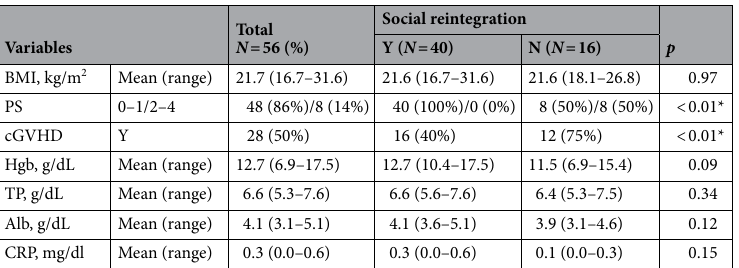
Table 2. Patient status at 2 years after allo-HSCT. BMI; body mass index, PS; performance status, cGVHD; chronic graft-versus-host disease, Y; yes, Hgb; hemoglobin, TP; serum total protein, Alb; serum albumin, and CRP; C-reactive protein. *indicates statistically